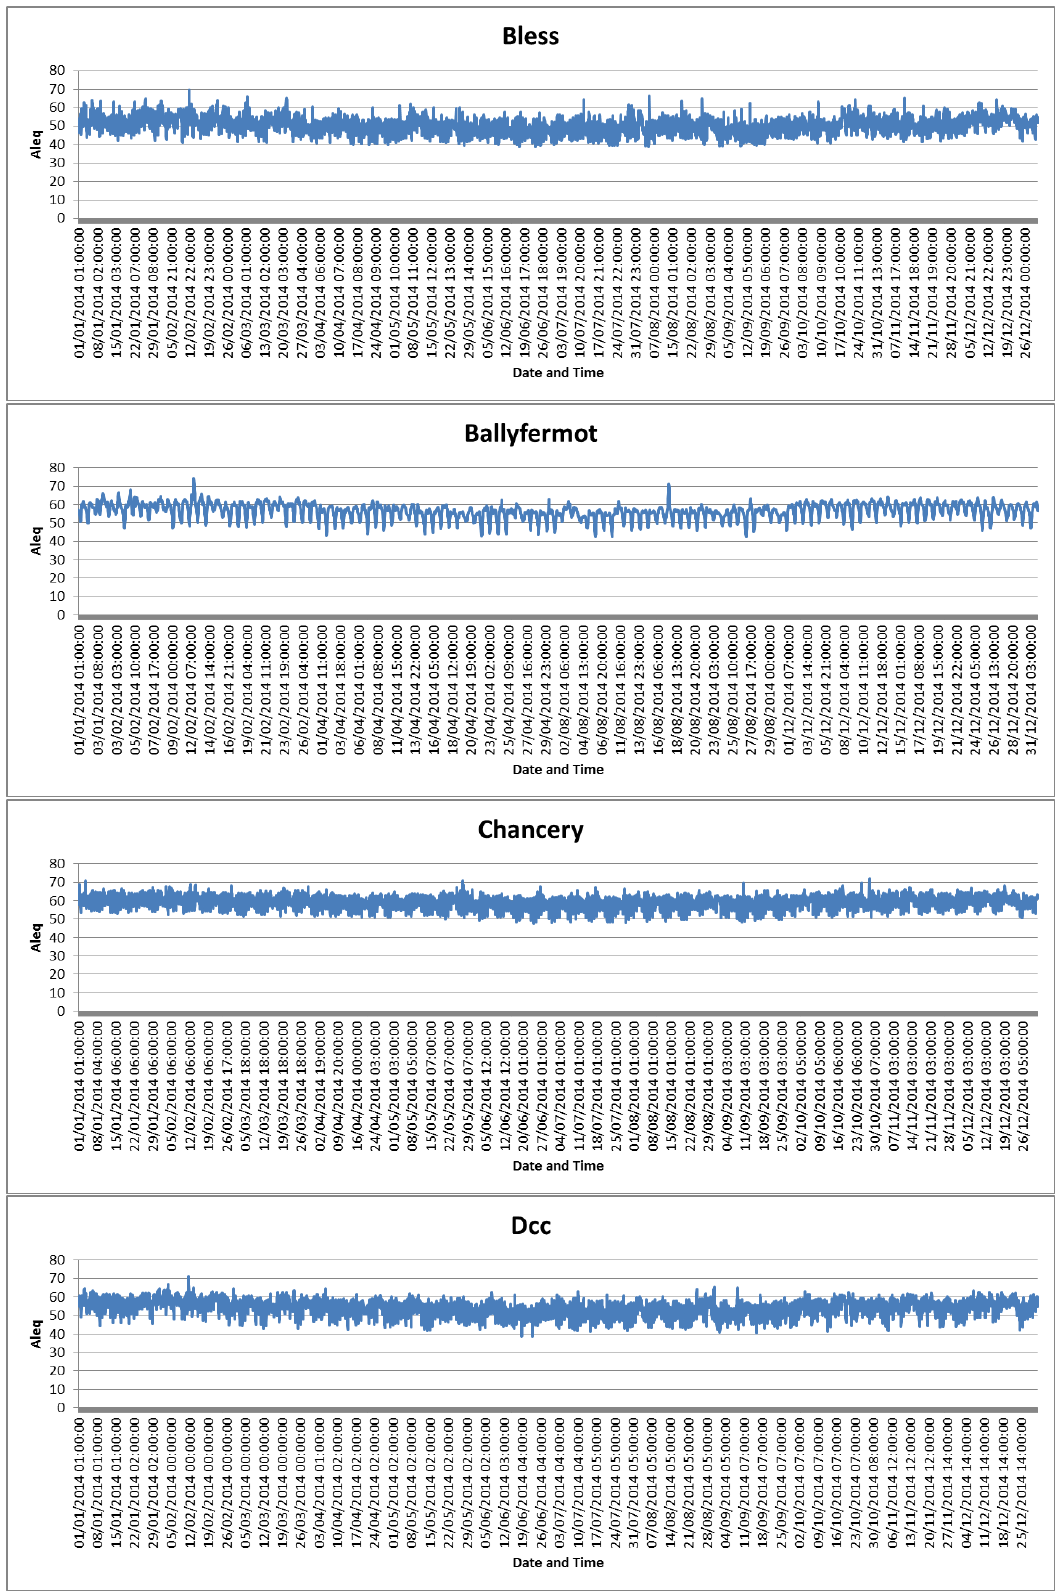
Supplementary Figure 3: AL eq at hourly resolution